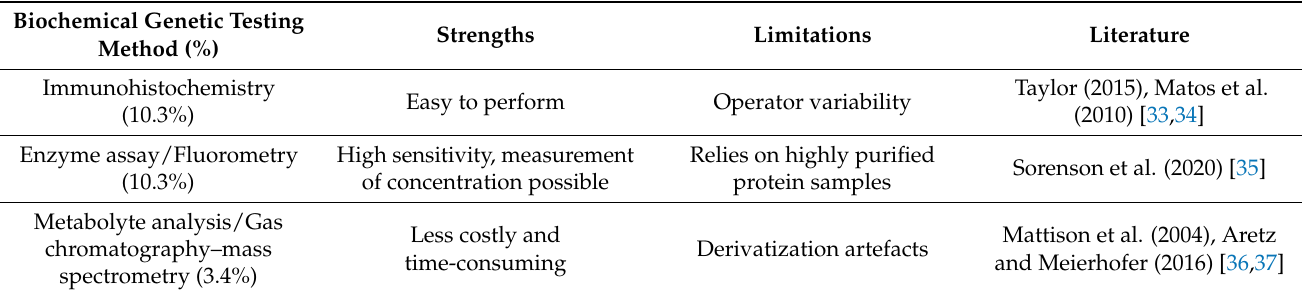
Table 3. Strengths and Limitations of biochemical genetic testing methods registered in the GTR for the PharmGKB-listed drugs with required or recommended testing according to the respective